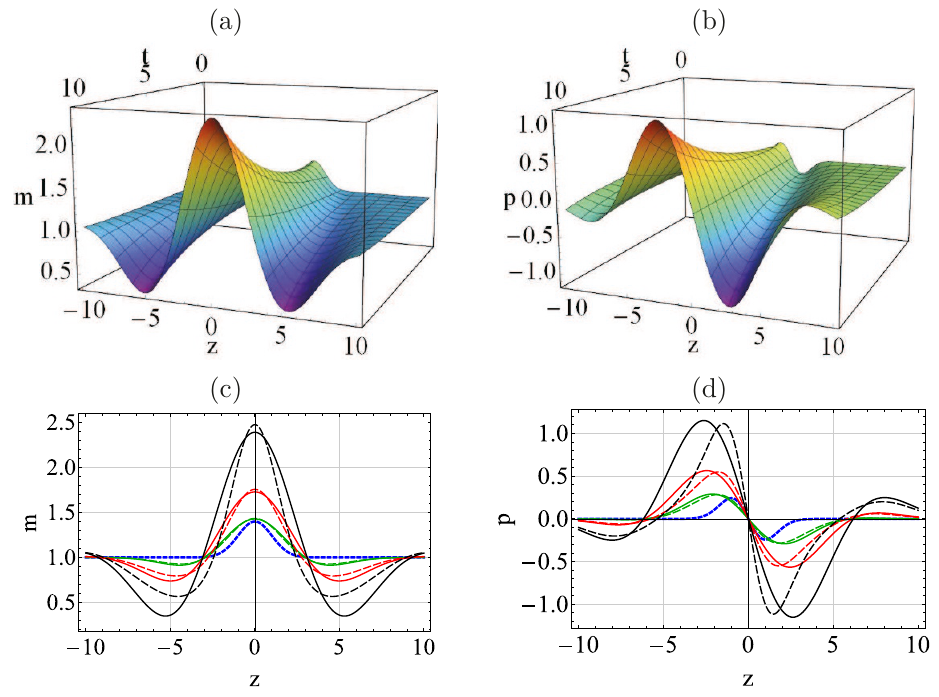
Figure 2 . Three-dimensional plots of (a) 1+ m 1 ( t, z ) and (b) p 1 ( t, z ), given by eqs. (2.32) with β = b = 1 , z 0 = 0. The comparison between first-order solution (c) 1 + m 1 ( t, z ) (resp. (d) p 1 ( t, z )) and non-perturbative solution m ( t, z ) (resp. p ( t, z )) obtained by numerically solving eq. (2.1) and (2.2). The blue-dashed curve represents initial configuration m (0 , z ) (resp. p (0 , z )). The green, red, and black solid curves represent the first-order solutions at t = 3 . 3, 6 . 7, and 10, respectively. The (green, red, and black) dashed curves represent the full numerical solutions at the corresponding